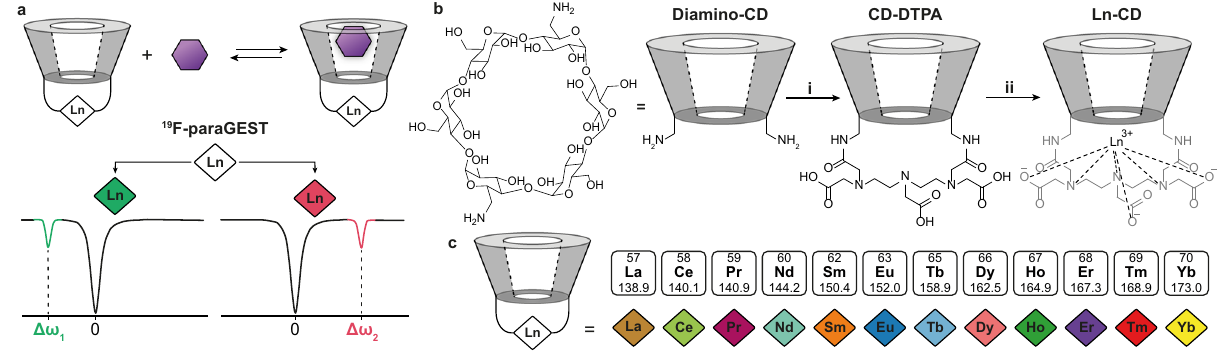
Fig. 1 COlor Display by Exploiting Host – guest Dynamics (CODE-HD) rationale and lanthanide-cyclodextrins (Ln-CDs) library fabrication. a The dynamic exchange process that allows a paramagnetic guest exchange saturation transfer (paraGEST) observation and two schematic z-spectra showing different chemical offsets ( Δ ω 1 , green, and Δ ω 2 , pink) values, when using different Ln-CDs (green and pink diamonds). b The synthetic route used for the synthesis of Ln-CD: (i) diethylenetriaminepentaacetic dianhydride and triethylamine, in anhydrous dimethyl sulfoxide (DMSO) at room temperature for 16h; (ii) re fl ux in aqueous Lanthanide chloride (LnCl 3 ) solution for 1 h, -hydrochloric acid (HCl). c The constructed Ln-CD library with the different Ln used represented as color